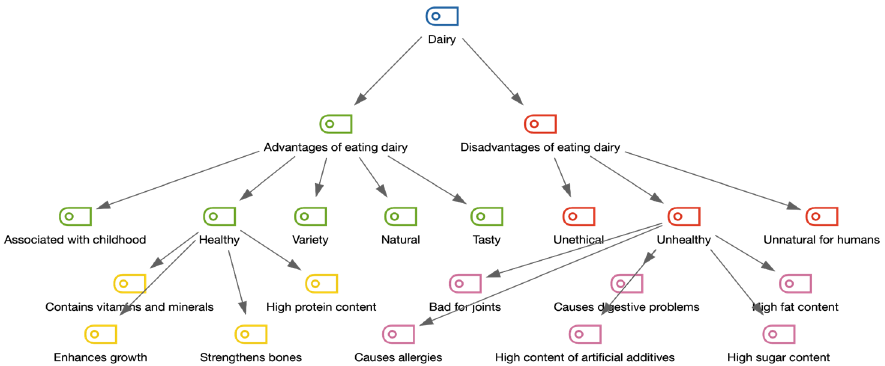
Figure 1. Visualization of codes connected to dairy consumption (network of associations regardless of frequency).